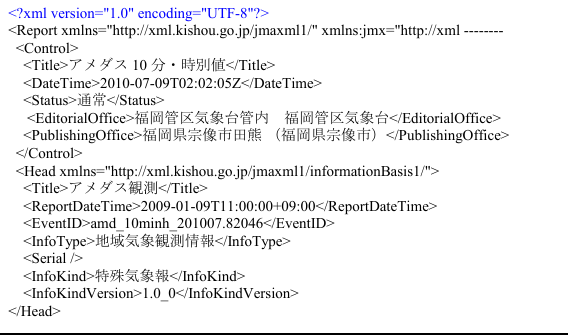
Figure 8. New AMeDAS data DPI XML